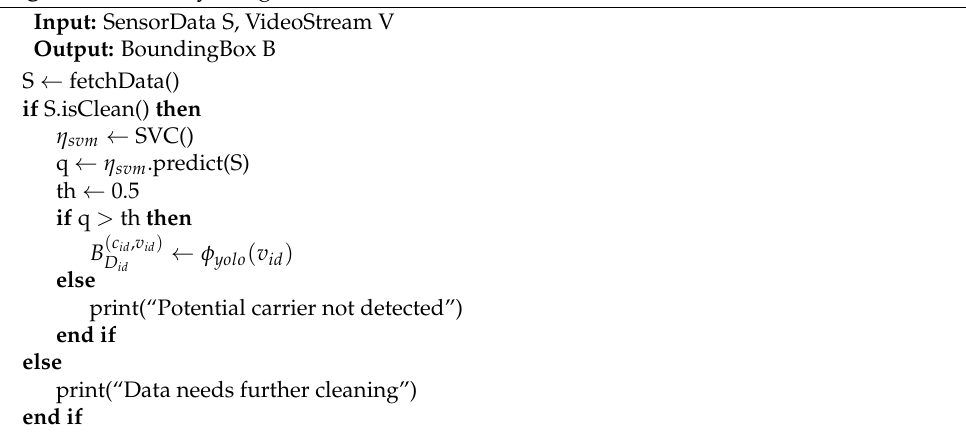
Algorithm 1 AI layer algorithmic flow for carrier